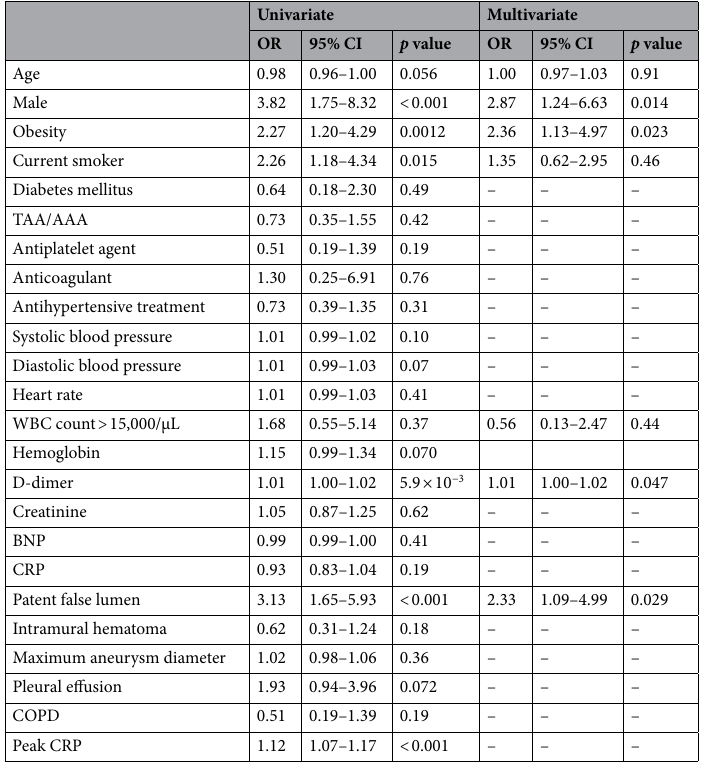
Table 2. Univariate and multivariate logistic regression analysis of in-hospital hypoxemia. CI confidence interval, OR odds ratio, TAA thoracic aortic aneurysm, AAA : abdominal aortic aneurysm, WBC white blood cell, CRP C reactive protein, BNP brain natriuretic peptide, COPD chronic obstructive pulmonary